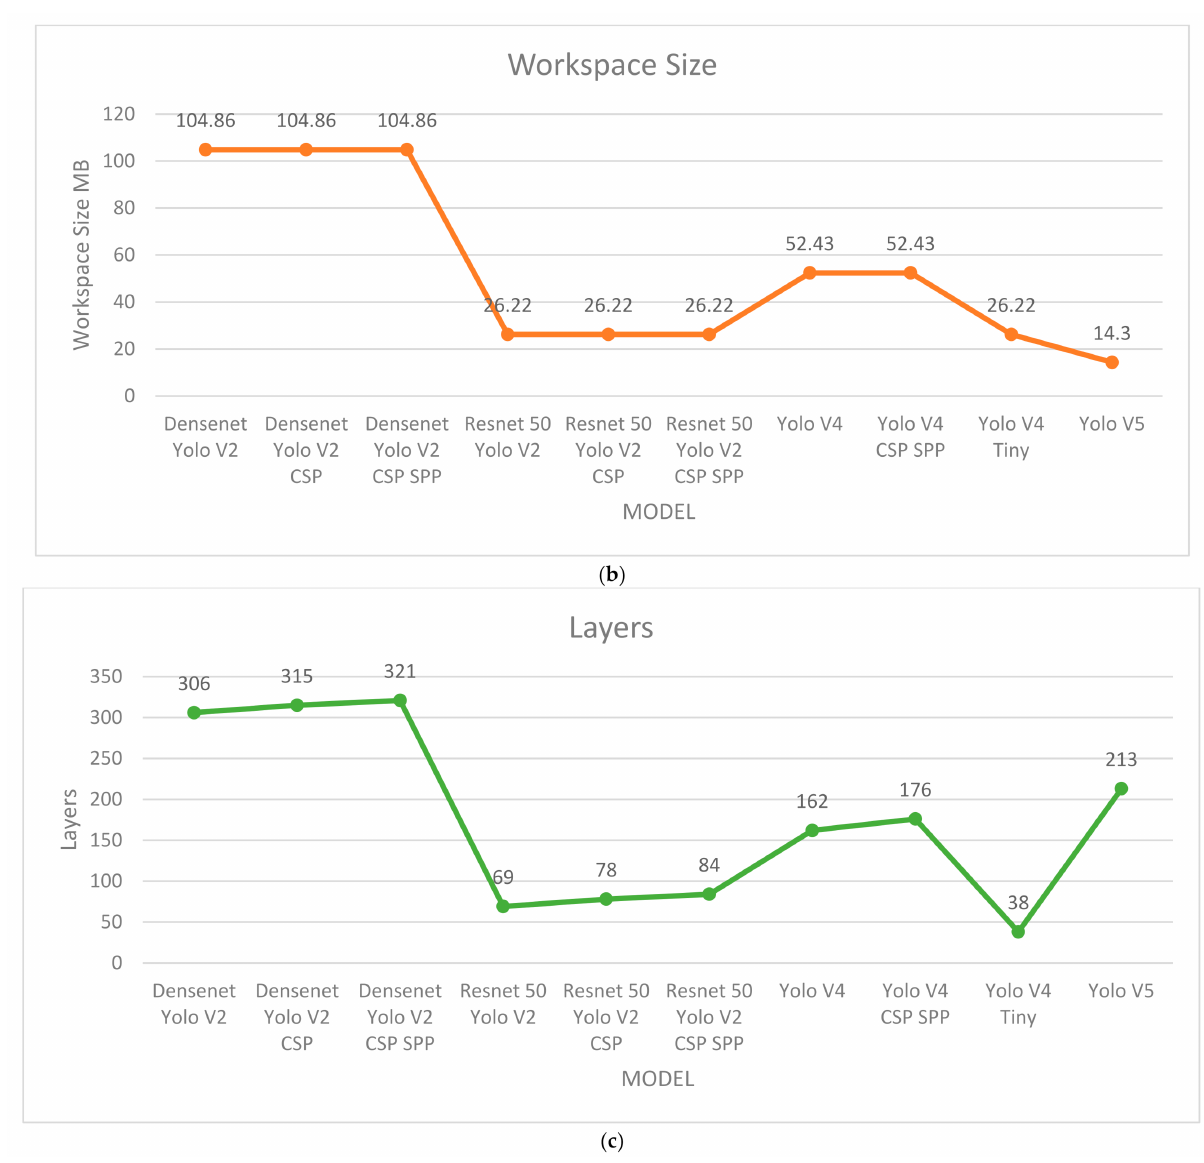
Figure 10. Comparison of ( a ) BFLOPS, ( b ) workspace size, and ( c ) number of